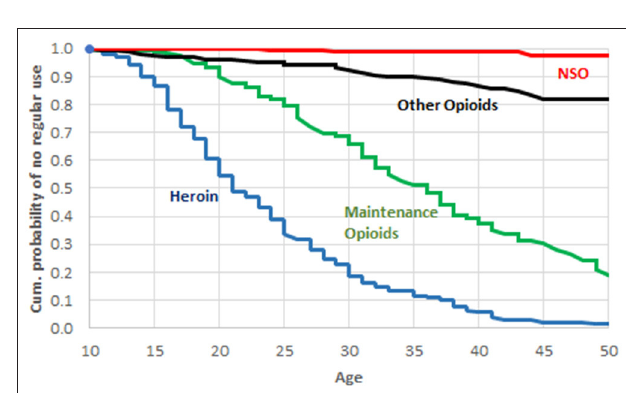
FIGURE 2 | Cumulative probability of no regular use during